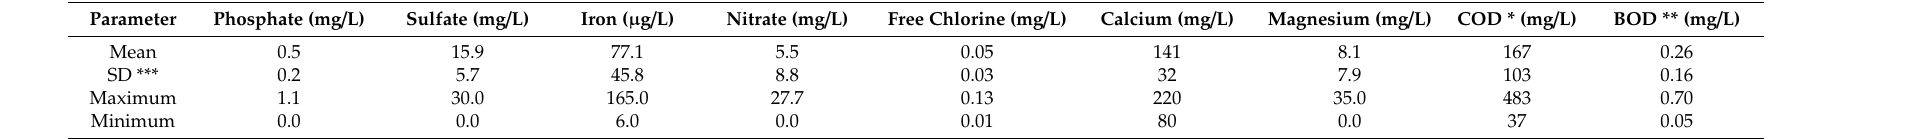
Table 2. Descriptive statistics of the water quality values of all sampling